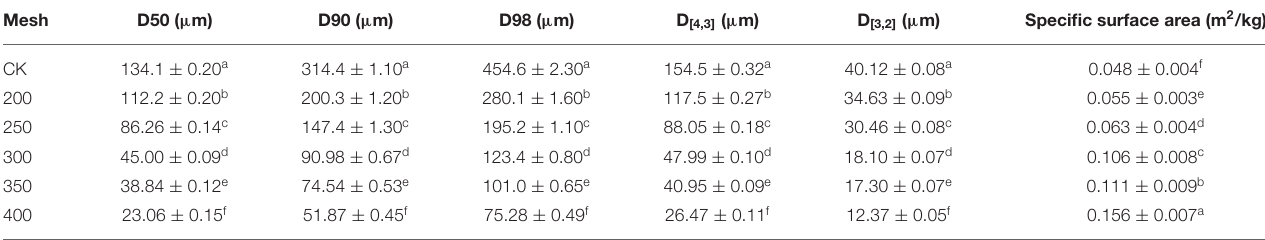
TABLE 1 | Particle size distribution of IDF from corn bran.